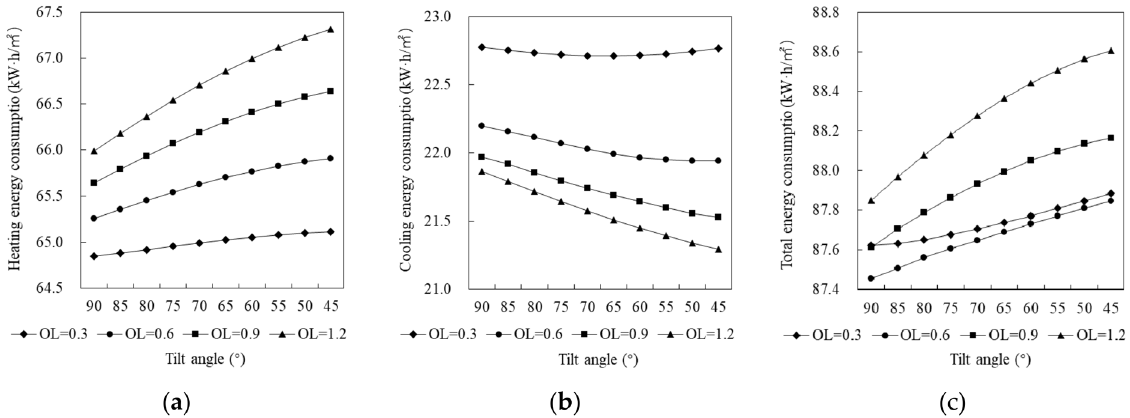
Figure 15. Relationships between tilt angle and energy consumption: ( a ) heating; ( b ) cooling; ( c ) total. Through the above analysis, three parameters have different influences on the energy consumption. There is closely related between the size and cost of shading system. So, the interaction between these parameters should be considered in the